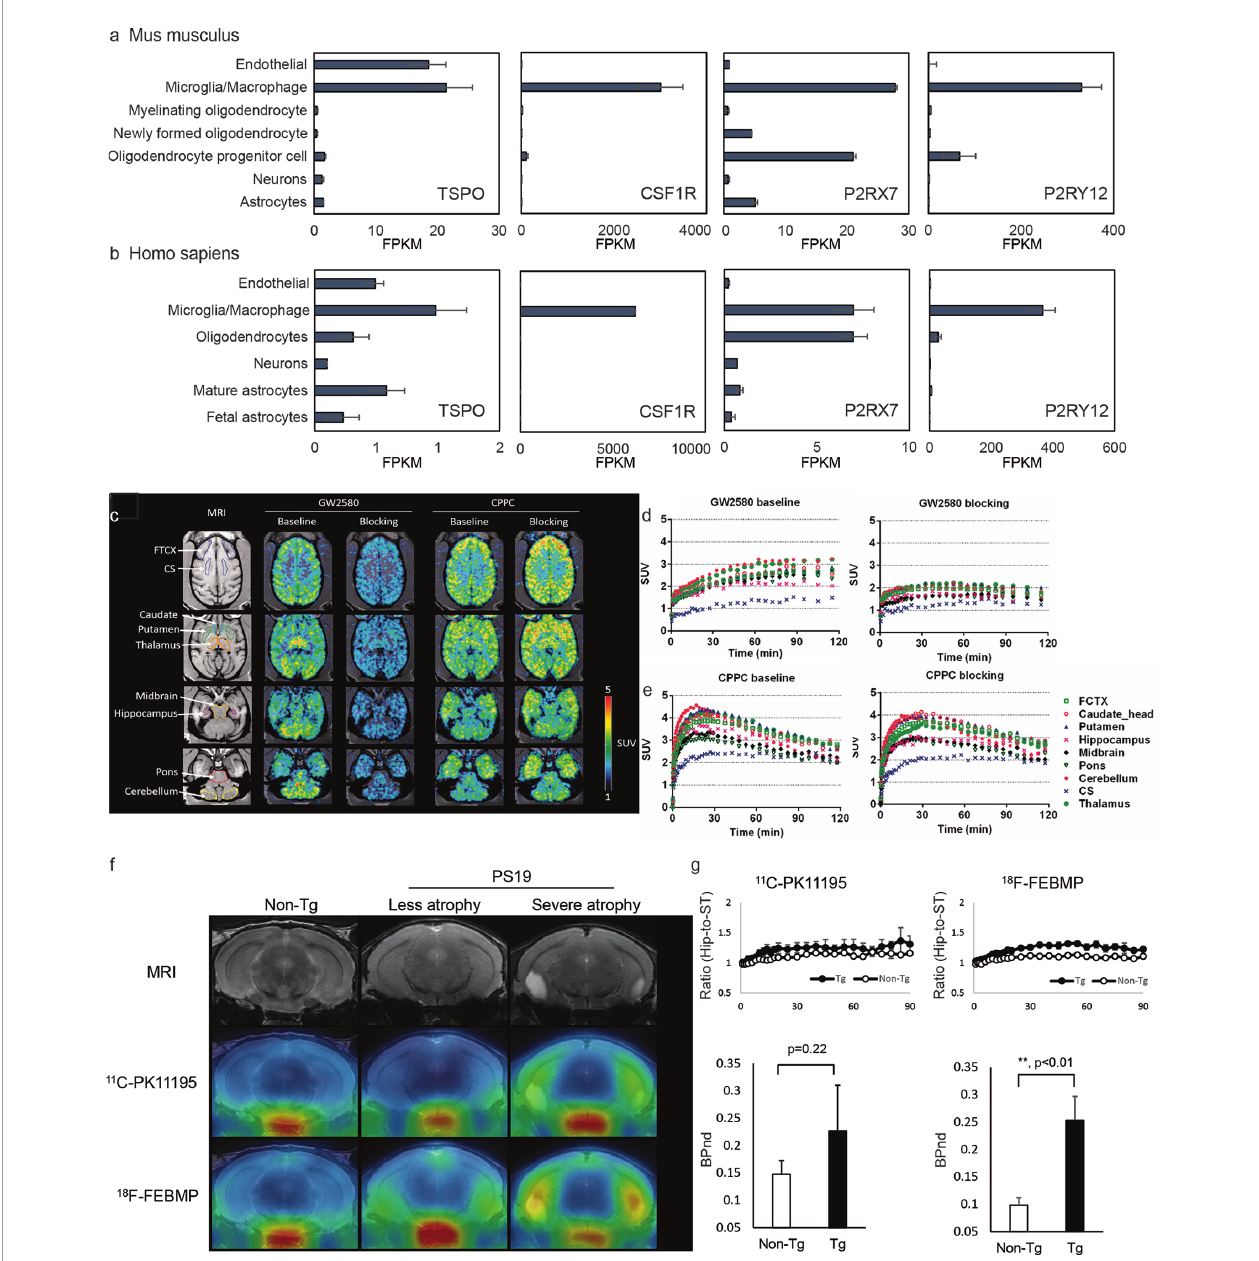
FIGURE 1 | Cellular location of emerging neuroin fl ammation imaging targets. (A, B) The RNA expression of TSPO, CSF1R, P2RX7 , and P2RY12 in mouse (A) and human (B) brain [based on RNA-Seq data (189, 190)]. FPKM, fragments per kilobase of transcript per million mapped reads. Reproduced from https://www. brainrnaseq.org and (189, 190) with permission. (C) Representative transverse planes of [ 11 C]GW2580 and [ 11 C]CPPC SUV 60-120min images of a monkey brain superimposed on the monkey ’ s own MR images at baseline and with a homologous blocker treatment. (D, E) Time – radioactivity curves of [ 11 C]GW2580 and [ 11 C] CPPC in various brain regions obtained from corresponding PET images. FCTX, frontal cortex; CS, centrium semi-ovale. Reproduced from (64) with permission from Sage Publication. (F, G) Tau lesion-associated microglial TSPO was more sensitively captured by in vivo positron emission tomography (PET) imaging with [ 18 F] FEBMP than [ 11 C]PK11195. T2 magnetic resonance imaging (MRI) images and PET images with [ 18 F]FEBMP and [ 11 C]PK11195 in non-transgenic, and PS19 mice with less and severe brain atrophy at 9 months of age (F) . Time course of hippocampus (Hip)-to-striatum (ST) ratios of radioactivity and binding potential (BPnd) calculated by simpli fi ed reference tissue model with striatum as reference tissue showing signi fi cantly increased [ 18 F]FEBMP but not [ 11 C]PK11195 signal in PS19 compared with non-transgenic mice (G) . Reproduced from (57) with permission from Sage